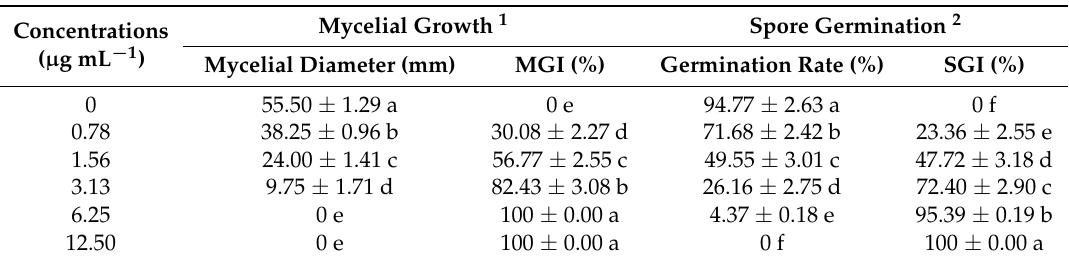
Table 1. Effect of different DEM concentrations on mycelial growth and spore germination of P. italicum after incubation at 27 ± 1 °C.